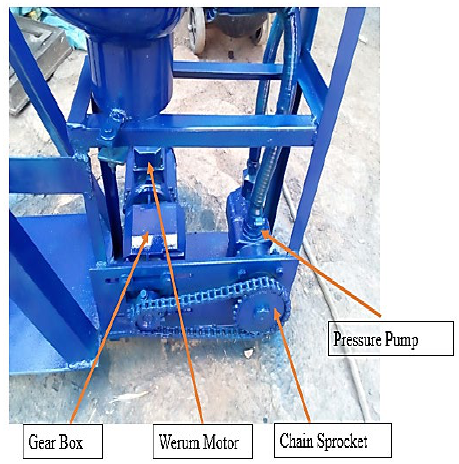
Figure 10. Components of hydraulic lateral load machine.